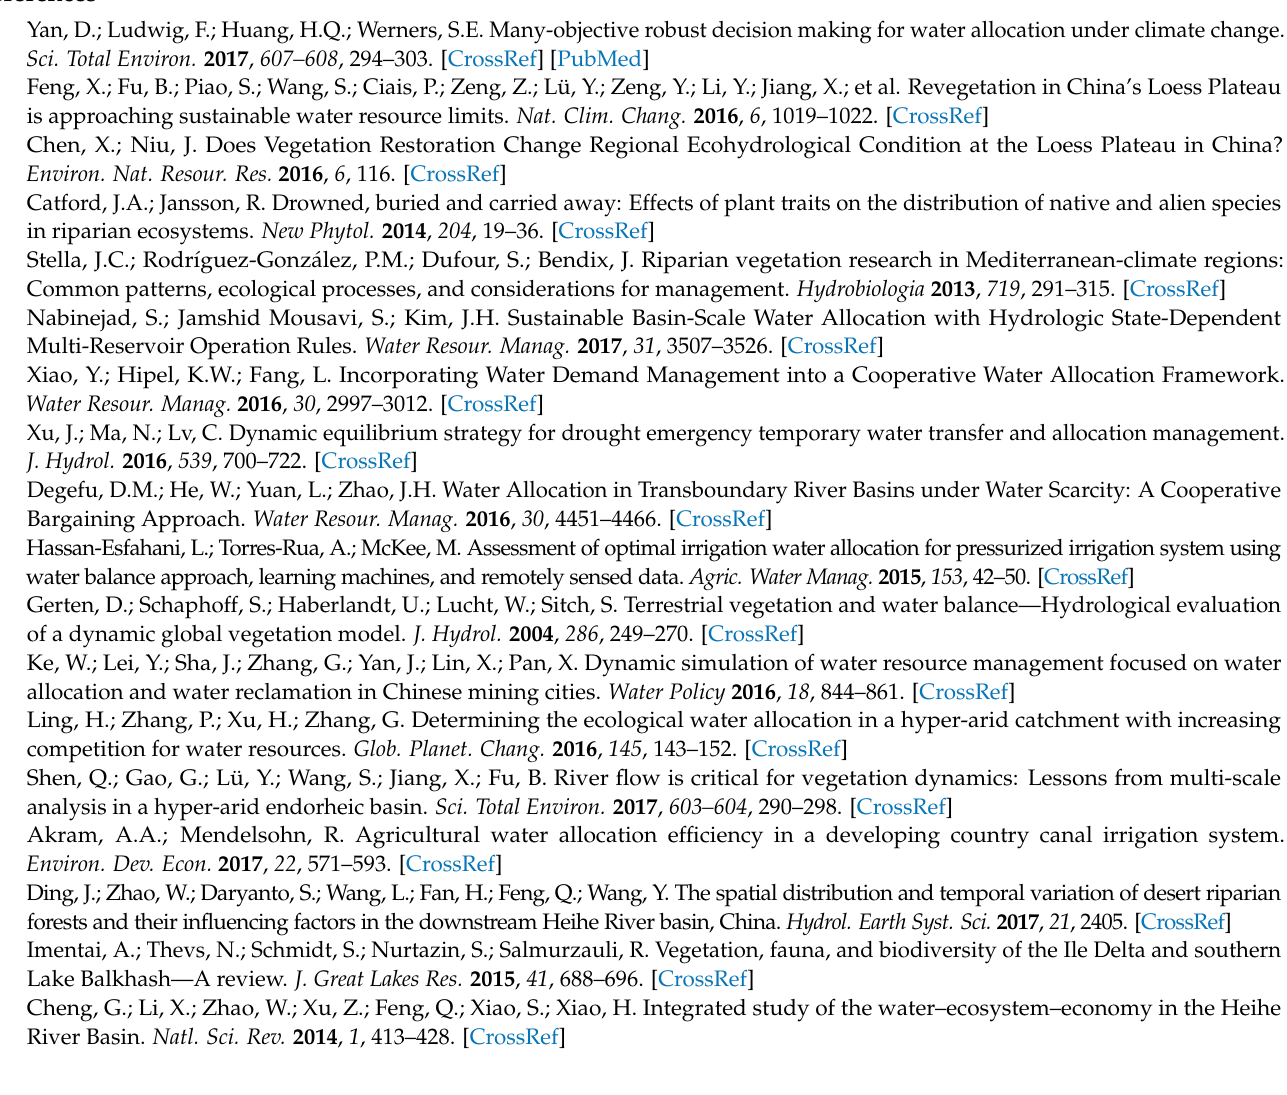
Figure S2: The Robust STR decomposition for NDVI max time series data. Figure S3: The Robust STR decomposition for NDVI min time series data, Figure S4: The Robust STR decomposition for NDVI most time series data. Figure S5: BIC and Residual sum of Squares (RSS) from abrupt chang detection showing the optimal numbers for breakpoints in NDVI categories